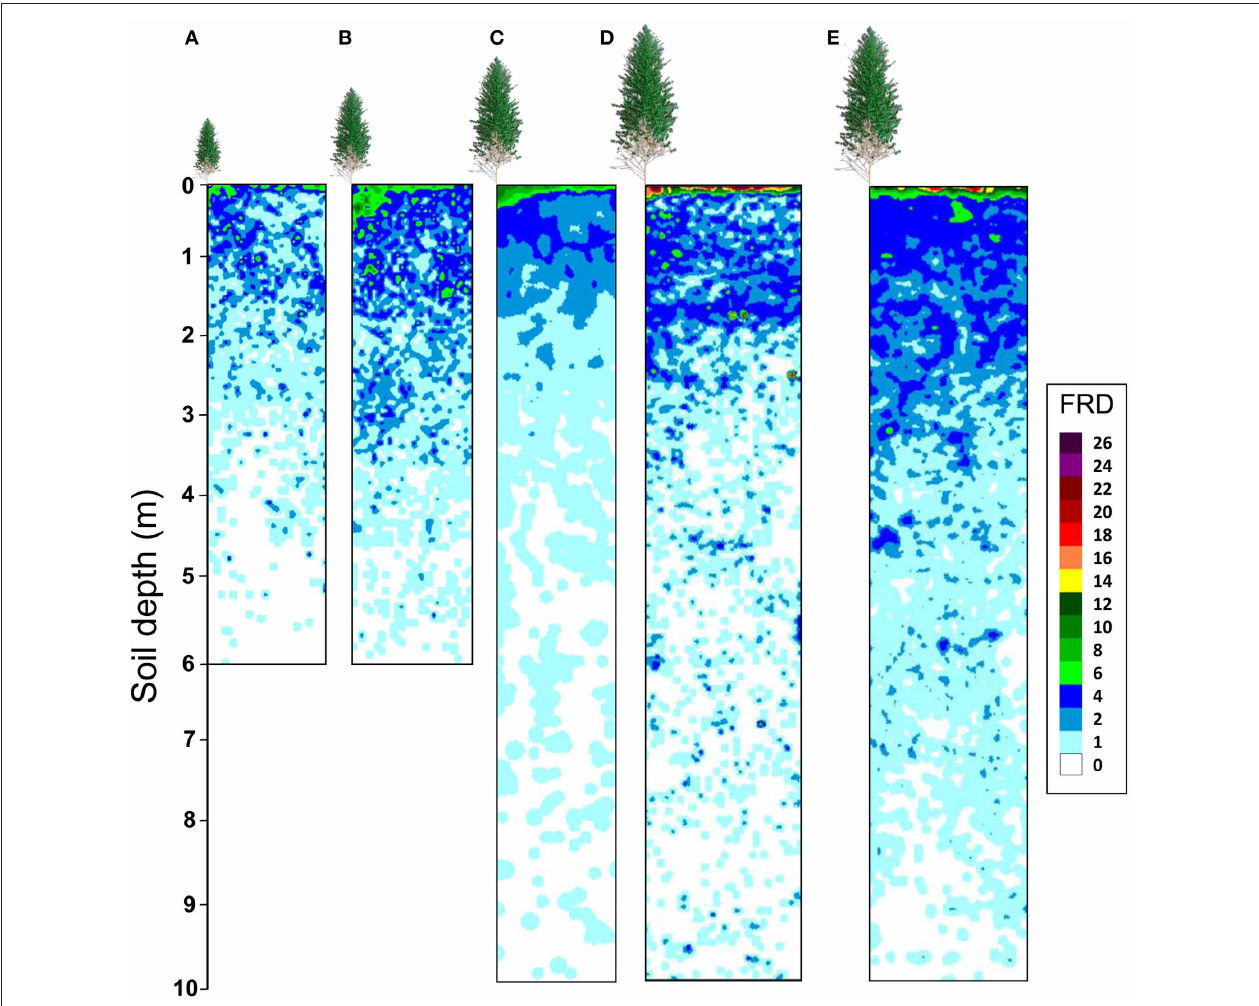
FIGURE 4 | Kriged maps of roots less than 1mm in diameter (FRD, number of root intersects counted in a 25cm 2 area of trench wall) on the P0 soil profile. Pits were at right angles to planting rows in a chronosequence of Eucalyptus grandis plantations down to a depth of 6m at 1 and 2 years after planting ( A and B , respectively) and down